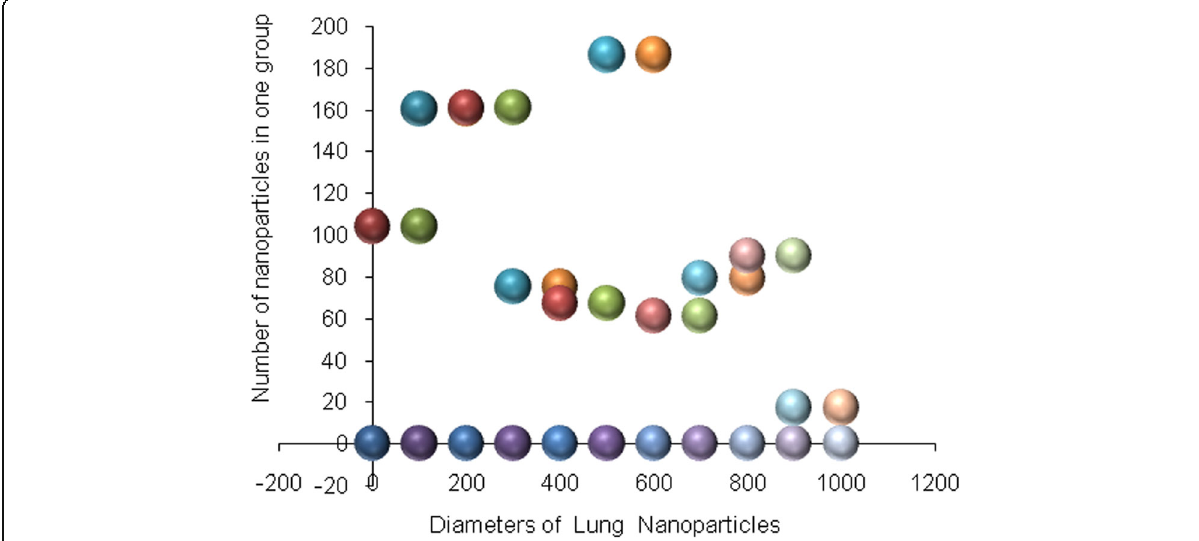
Fig. 7 Group of nanoparticles in the lung cells and their number in one of the proposed groups